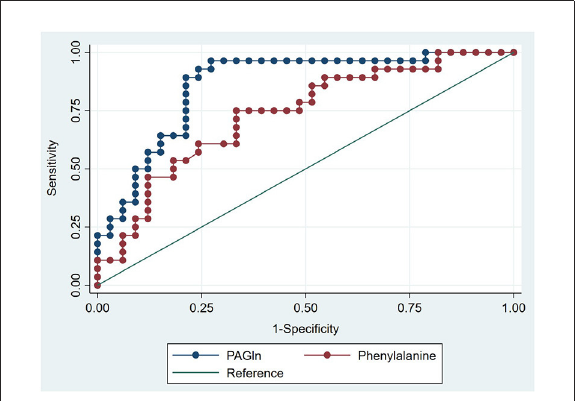
FIGURE3 ROC curve analysis for the plasma phenylalanine level in predicting ISR. The AUC was 0.732 (95% CI: 0.606–0.858, P = 0.002).